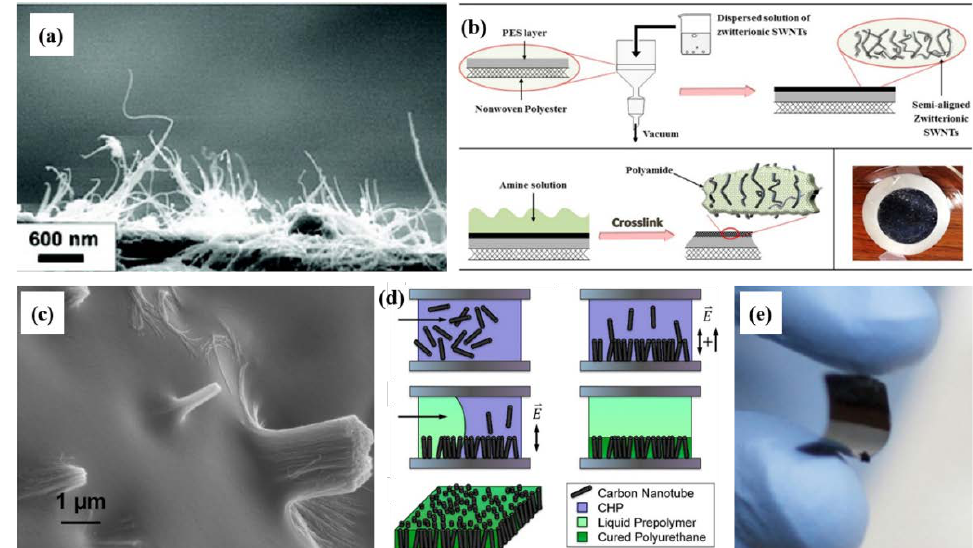
Figure 11. Various fabrication methods for large-scale manufacturing of vertically aligned carbon nanotube (VACNT) membranes. ( a ) Side-view SEM image of carbon nanotubes placed vertically on a polyvinylidene fluoride (PVDF) membrane filter [76]. ( b ) Schematic of the fabrication procedure of a zwitterion-functionalized single-walled CNT / polyamide (Z-SWNT / PA) nanocomposite membrane [140]. ( c ) SEM images of membranes with SWNT bundles protruding from the bottom surface. ( d ) Schematic representation of the E-field-assisted solvent deposition technique [88]. ( e ) Flexible VACNT membrane obtained by in-situ polymerization [74] .